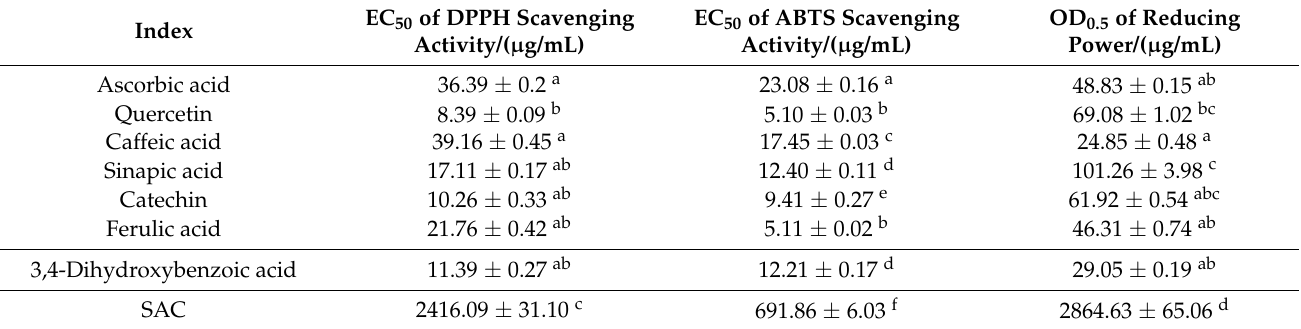
Table 1. EC 50 and OD 50 values of individual compounds for DPPH, ABTS, and reducing power assays.